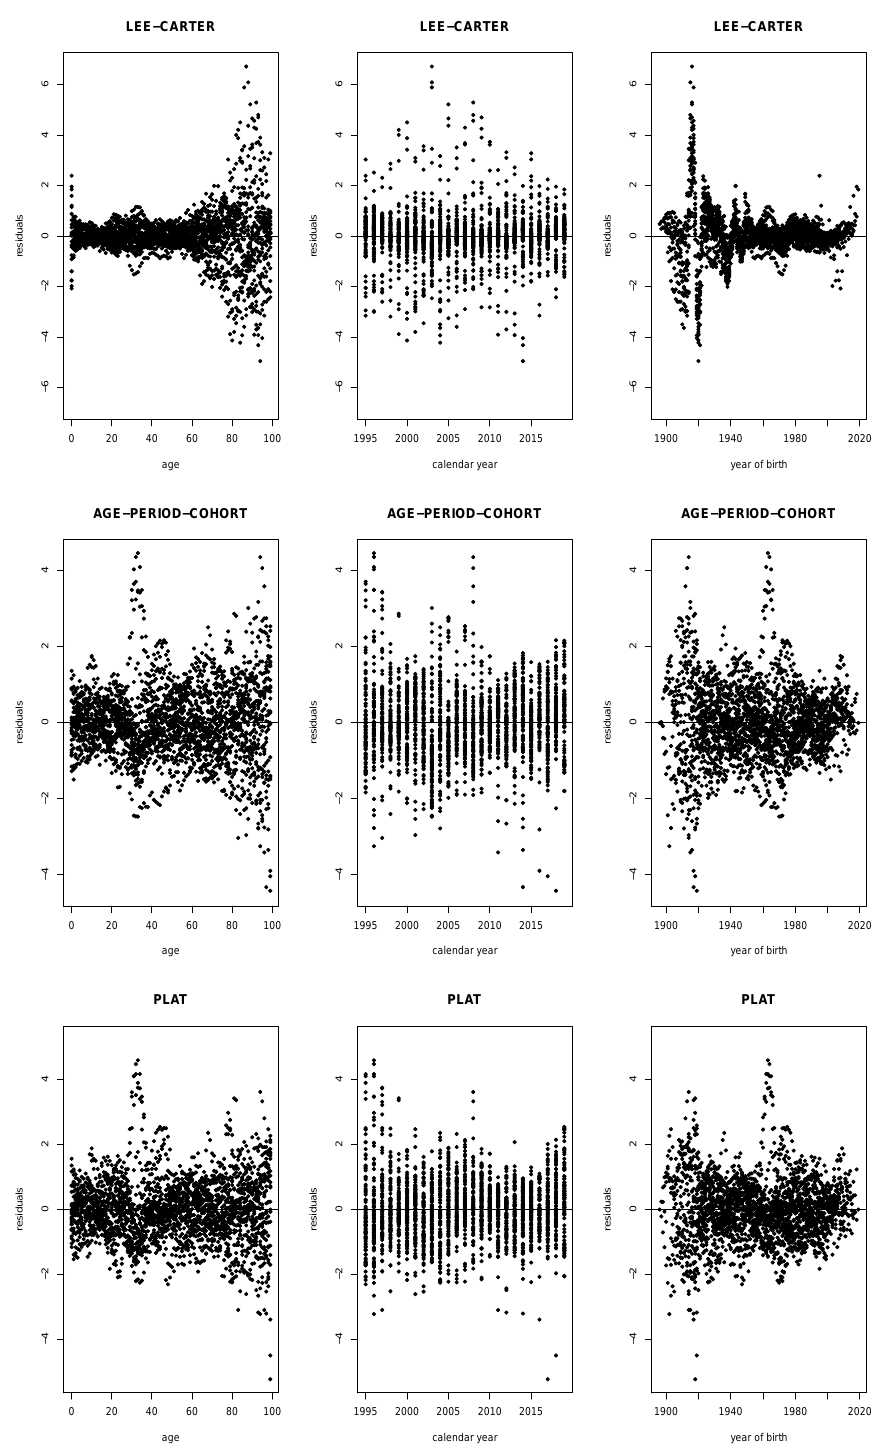
Figure A6. Comparison of LC, APC and PLAT Stochastic Mortality Models: residuals by age, period and